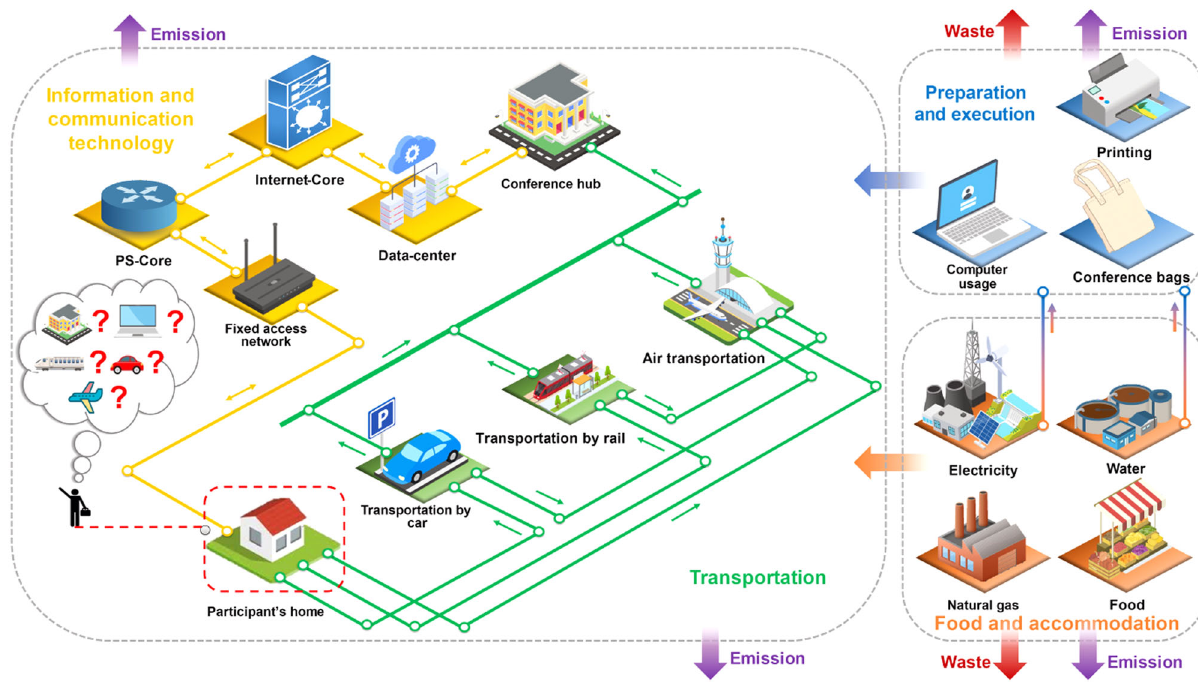
Fig. 1 Illustration of a hybrid conference that can be accessed by both in-person participants and virtual participants. Here we demonstrate the hybrid mode of a conference, where virtual participants are connected with in-person participants traveling to the conference hubs through video-conferencing technologies. Yellow lines indicate the virtual pathway, and green lines indicate the in-person pathway to approach the